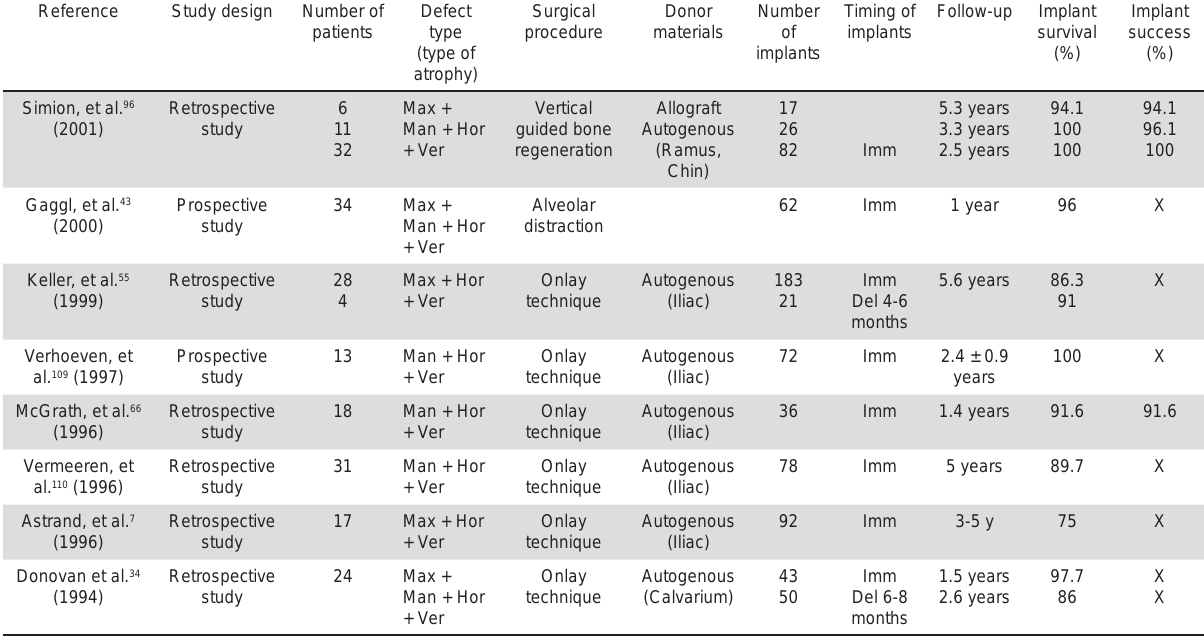
Table 2- Characteristics of the different vertical augmentation